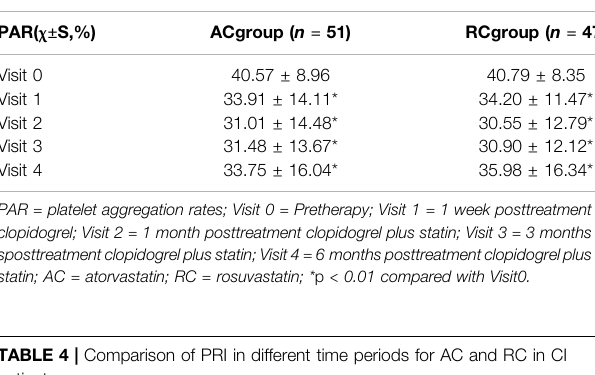
TABLE 3 | Comparison of PAR in different time periods for AC and RC in CI patients.